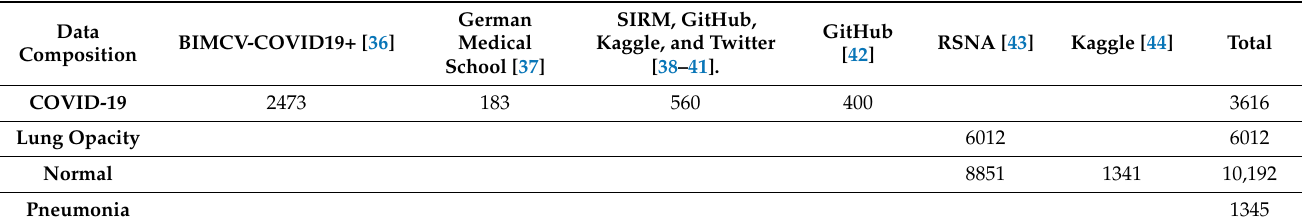
Figure 1. Sample images of original dataset [32,35]. Table 1. Composition of COVID-19 dataset